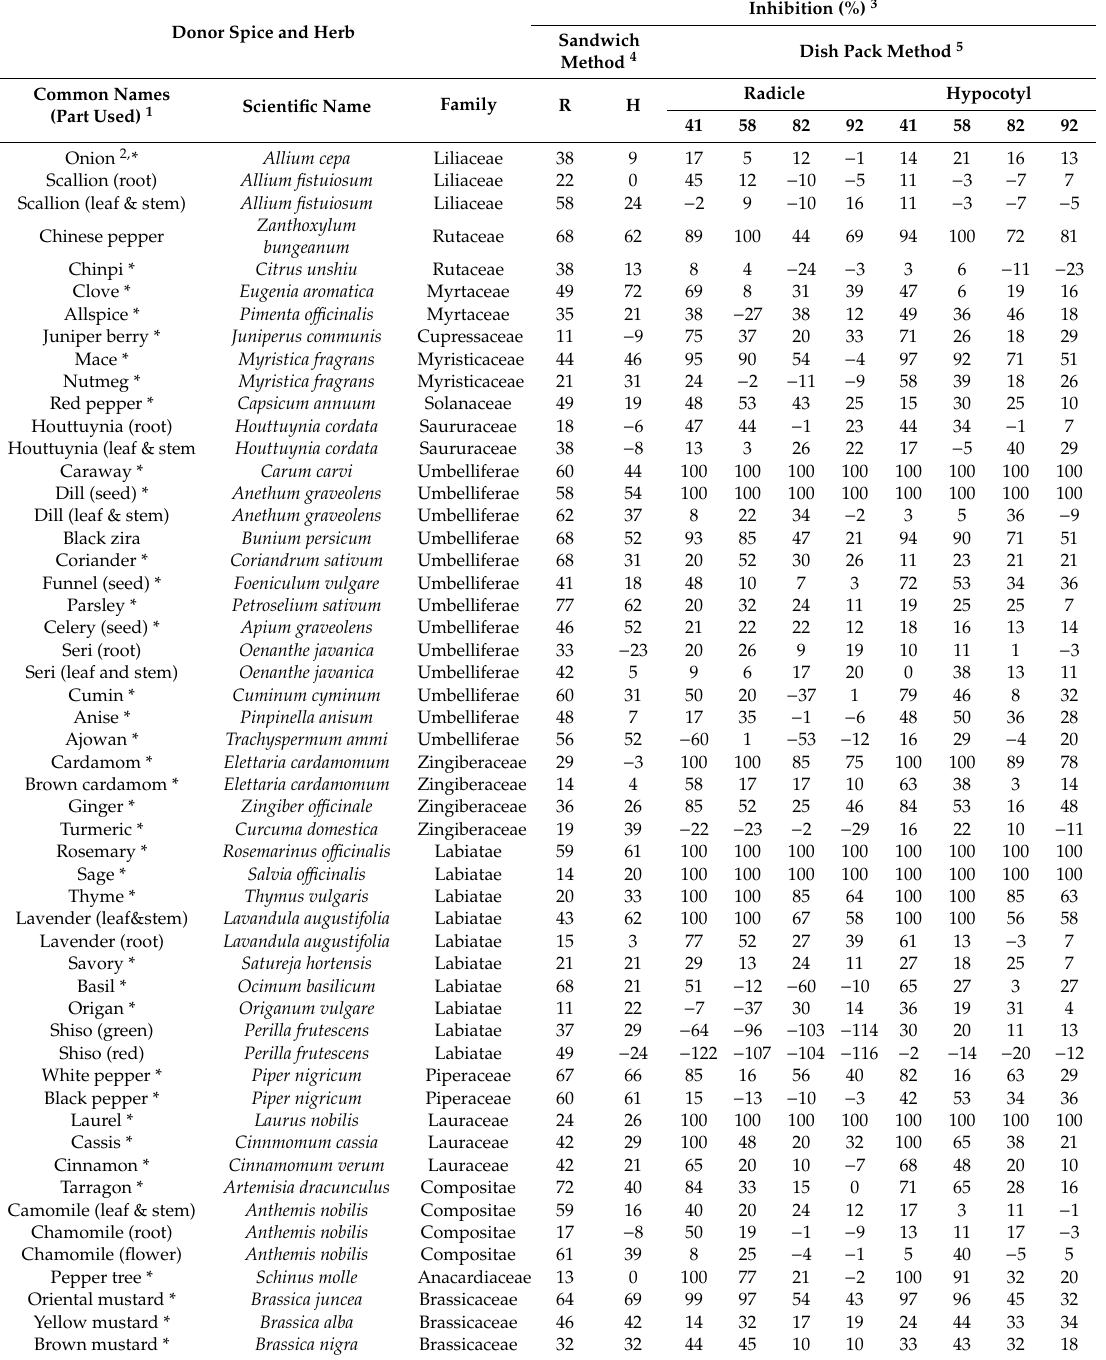
Table 1. Allelopathic activities of 53 spices and herbs based on the sandwich and dish pack methods. Donor Spice and